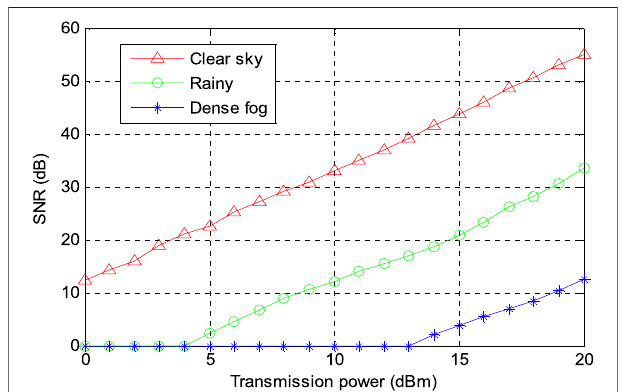
FIGURE 9 | Relationship between received BER and link distance for various atmospheric conditions.